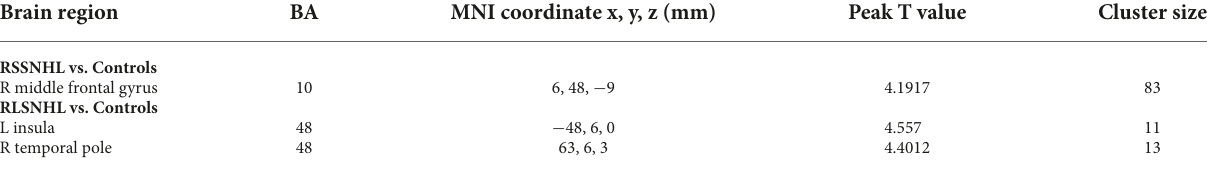
TABLE 3 Effective connections to right cerebellum lobe V among RSSNHL, RLSNHL, and Controls. Brain region BA MNI coordinate x, y, z (mm) Peak T value Cluster size